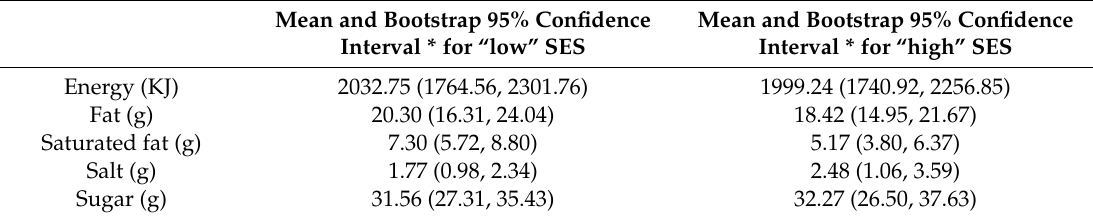
Table 4. Means and bootstrap confidence intervals for nutritional variables by socioeconomic status